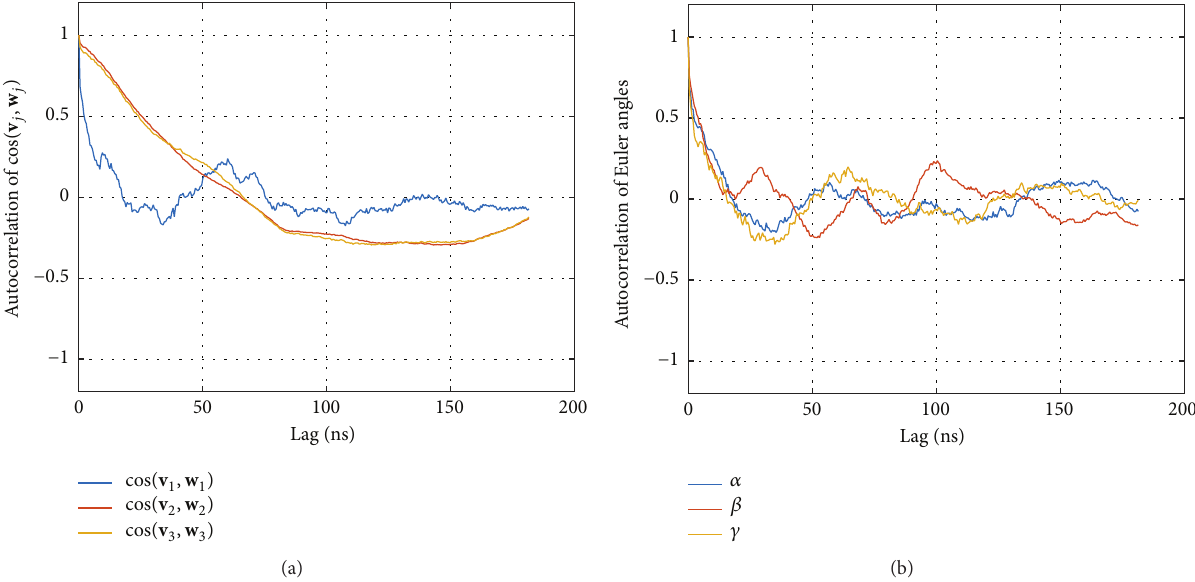
Figure7:AutocorrelationofrelativedirectionsofCD8andMHC 𝛼 3 .(a)Autocorrelationofcosinevaluesbetweencorrespondingeigenvectors (see legend box) of both domains over time. Every 10th frame is plotted. (b) Autocorrelation of Euler angles for the same data.